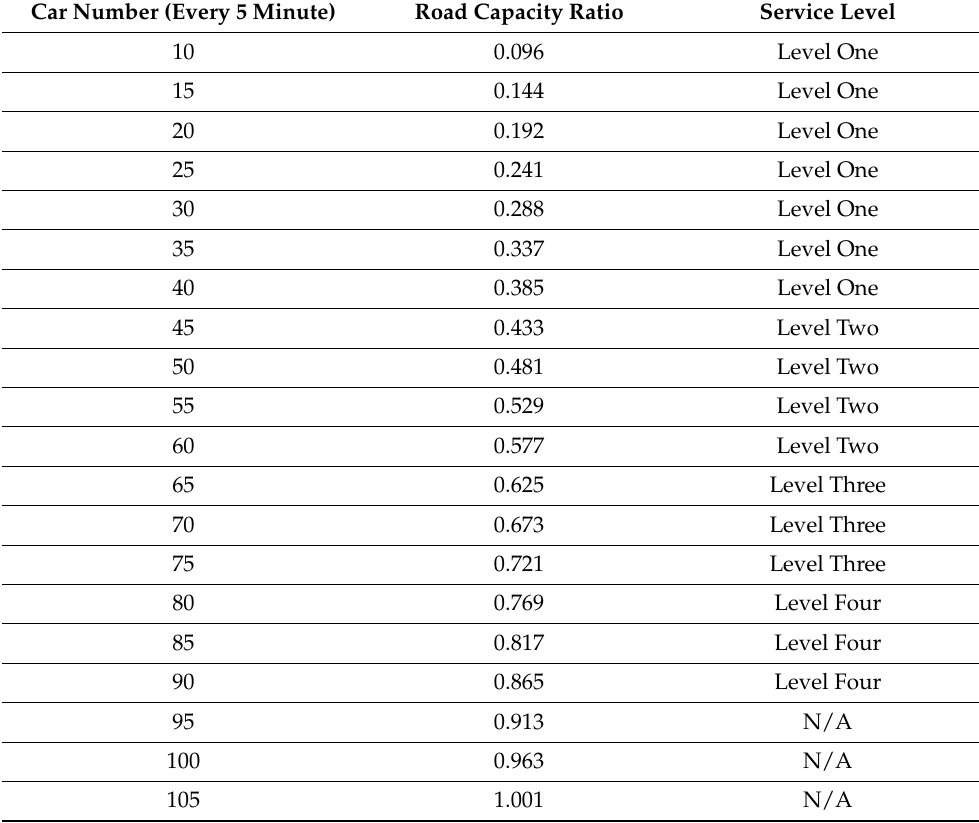
Table 9. The road occupancy ratio (China